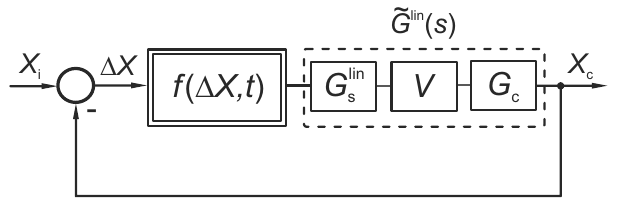
Figure 15. Hammerstein model of a nonlinear sensor in closed- loop configuration. The model comprises a static nonlinear part f ahead of a linear dynamic subsystem ˜ G lin is composed of the linear time-invariant part of the sensor trans- fer function as well as the linear amplifier and controller transfer